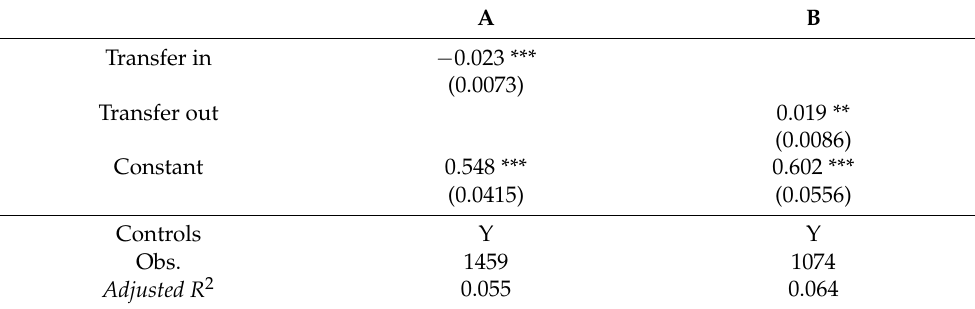
Figure 2. Common support assumption test for transferring-out land density distribution of p-scores before and after matching. ( a ) Transferring out before matching; ( b ) Transferring out after matching.